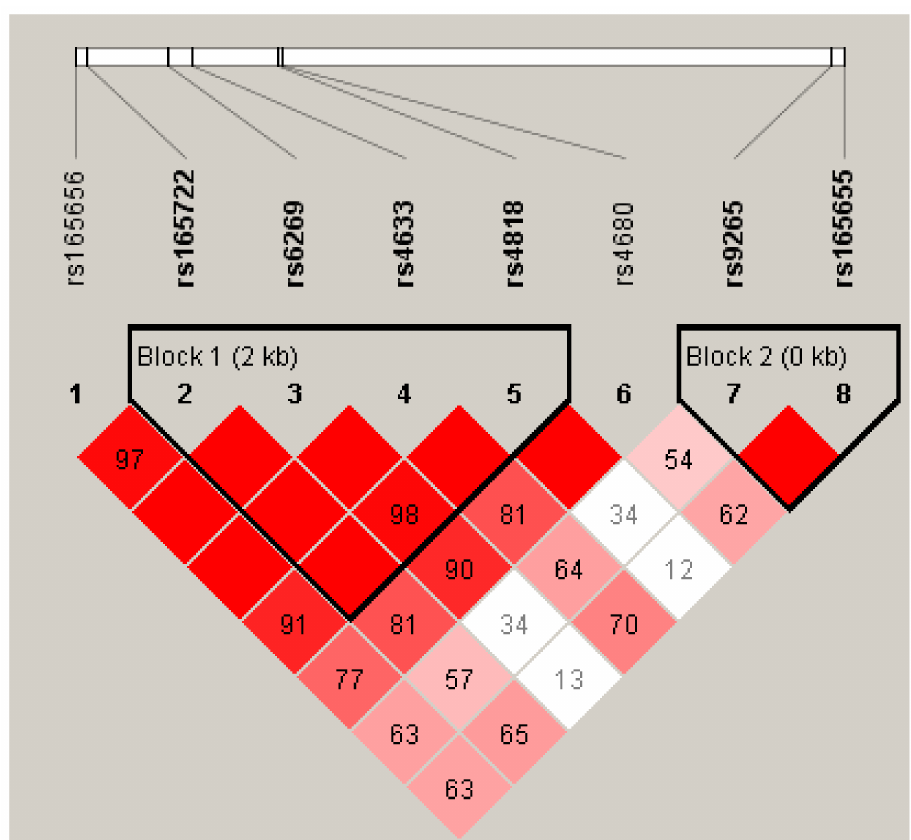
Figure 2. Linkage disequilibrium correlation coefficients of the COMT